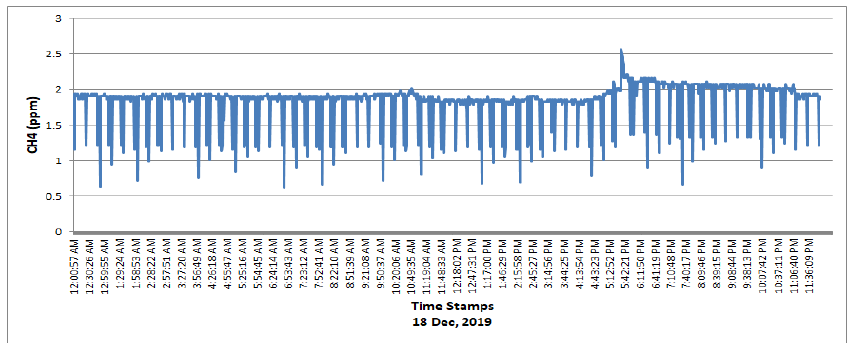
Figure 10. Variation in Concentration of Methane over a period of 24 h.